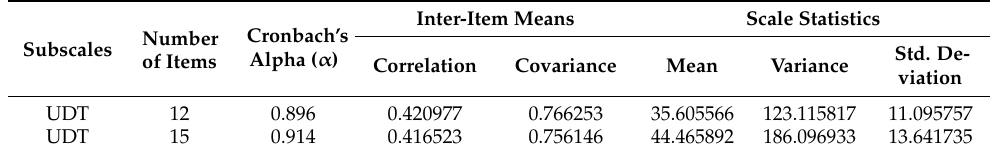
Table 7. Reliability analyses